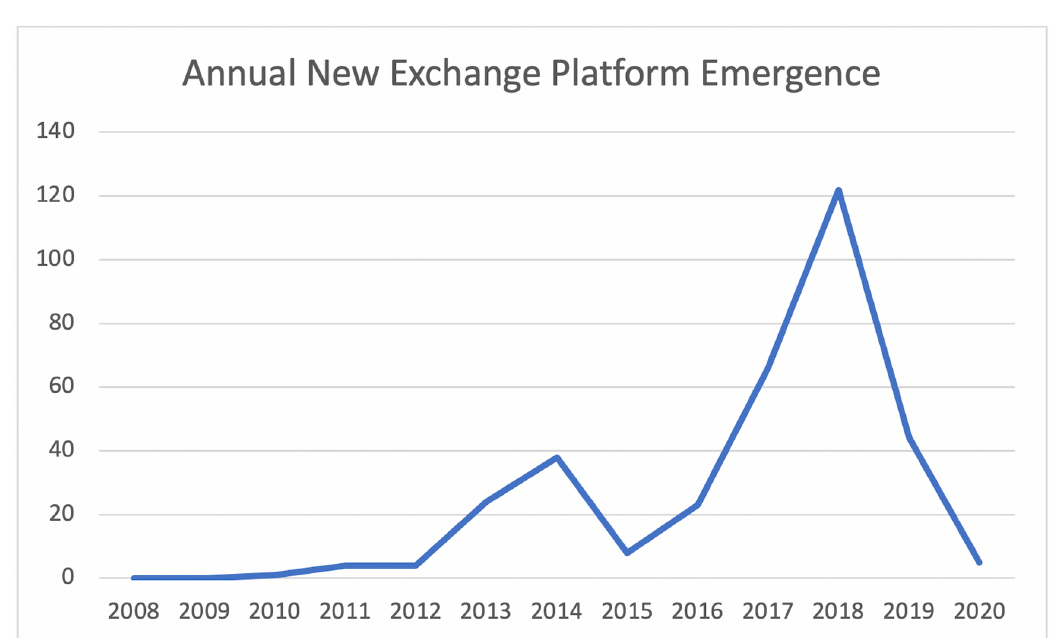
Figure 1: Frequency of New Exchanges Emerging Annually